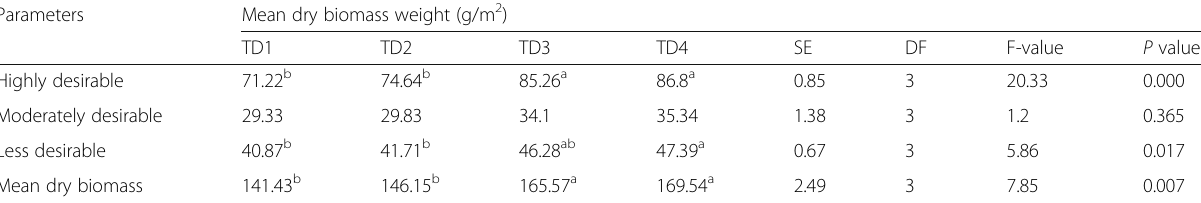
Table 4 Effects of grazing intensity on mean dry biomass weight of herbaceous species in Chagni ranch, Northwest Ethiopia